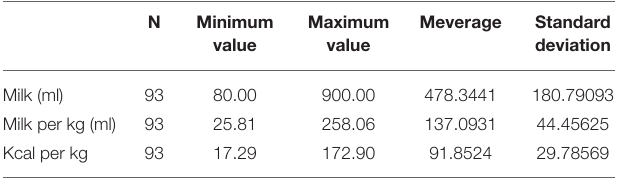
TABLE 3 | Feeding statistics before